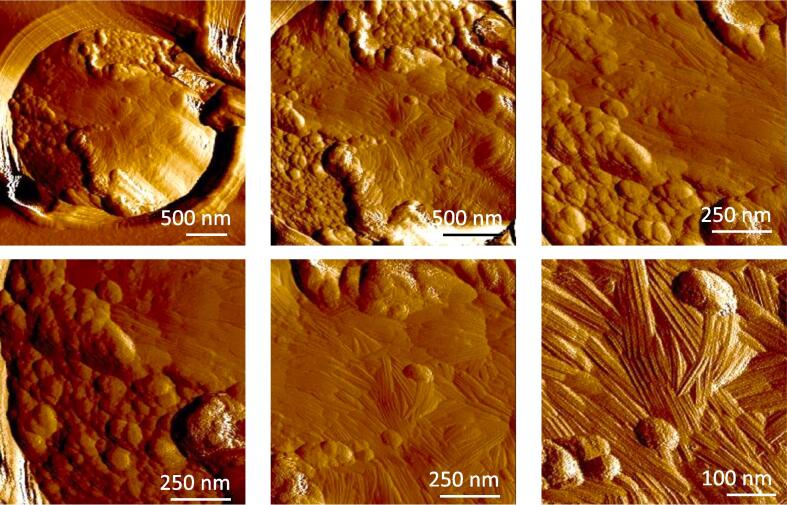
The surface of the RodA I115S/I146G double mutant is only partially covered by rodlets. AFM deflections images (at different magnification) representative of the conidium surface of the RodA I115S/I146G double mutant after 30 days of culture with different magnifications.